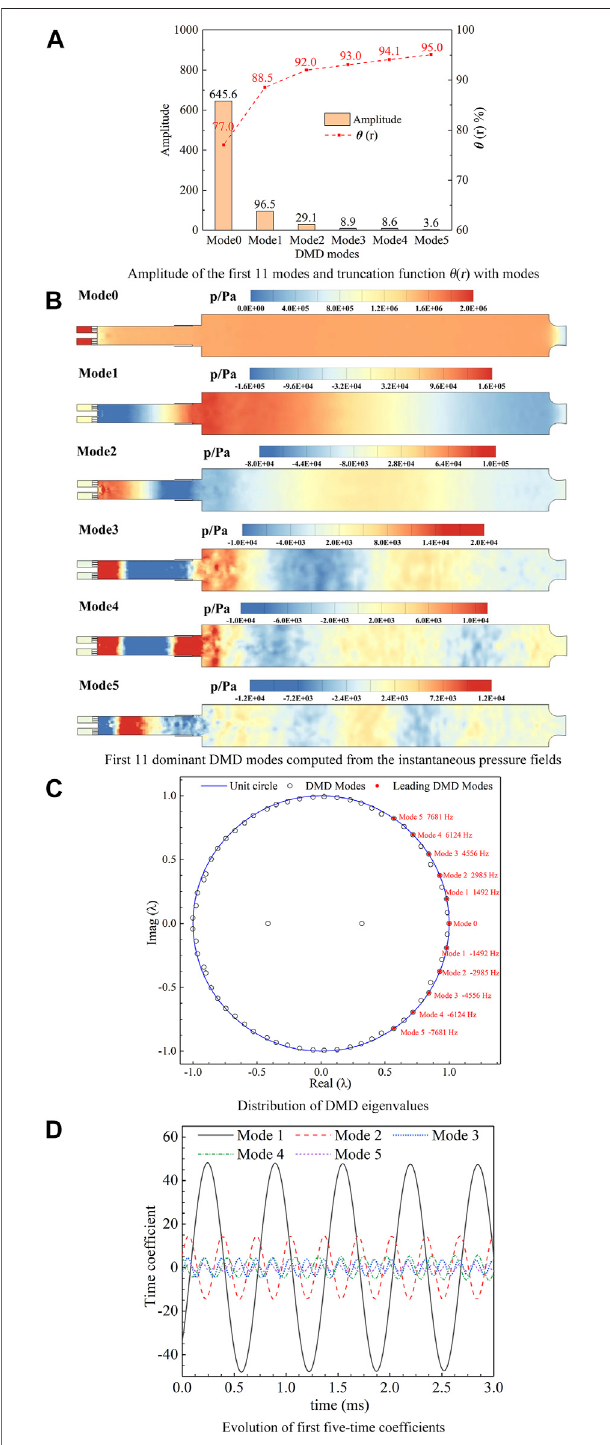
FIGURE 8 | DMD analysis results. (A) Amplitude of the fi rst 11 modes and truncation function θ ( r ) with modes. (B) First 11 dominant DMD modes computed from the instantaneous pressure fi elds. (C) Distribution of DMD eigenvalues. (D) Evolution of fi rst fi ve-time coef fi